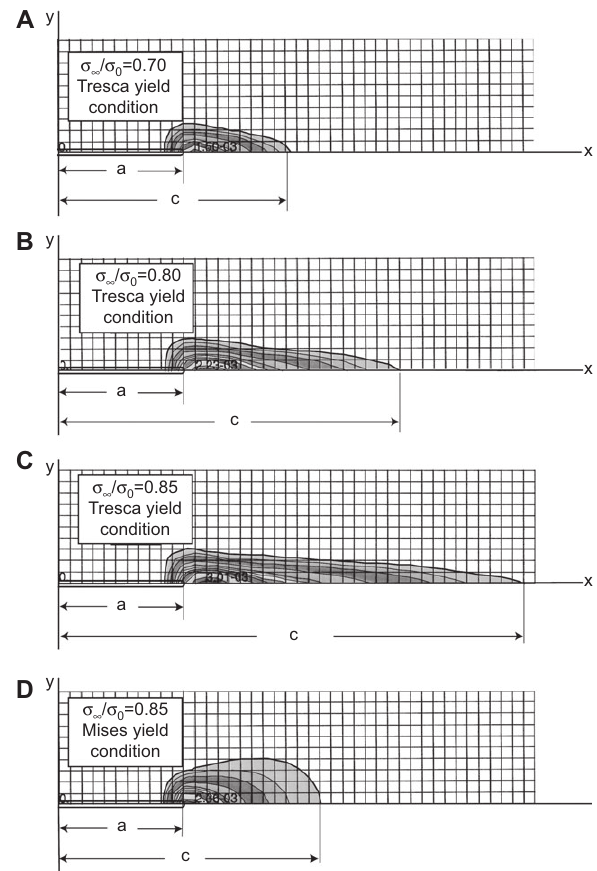
Figure 1 Effect of yield condition and applied load on equivalent plastic strain contours.